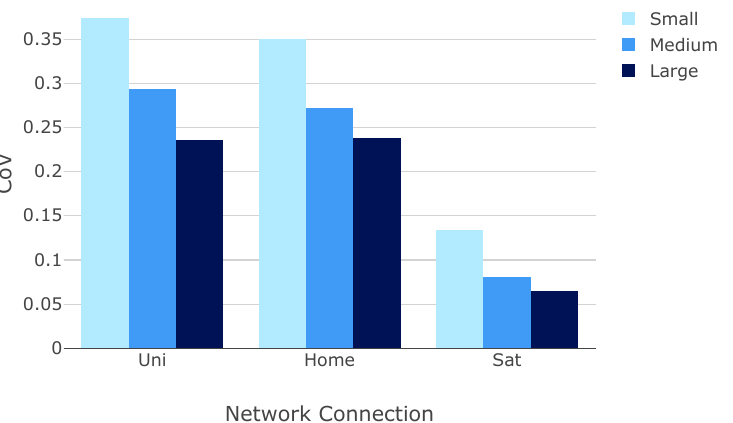
Figure 15. Coefficient of Variation calculated using all the video types and connections using locally hosted video files.